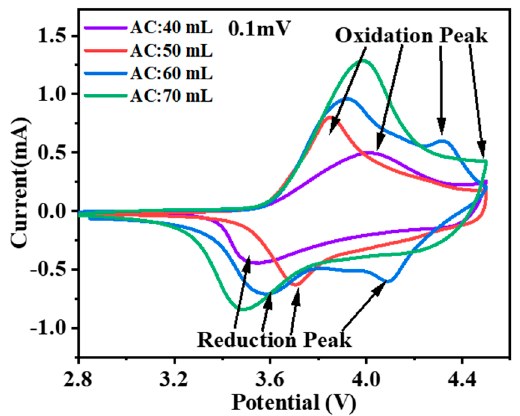
Figure 5. Cyclic voltammetry curve of NCM622 different ammonia content.